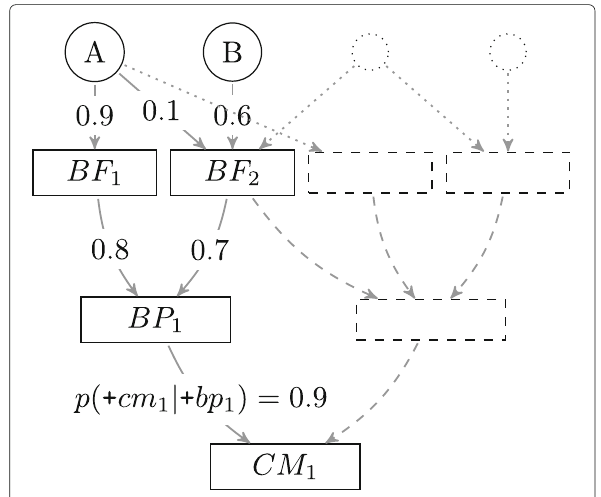
Fig. 1 Mission dependency model. Valuesalongedges denote individual conditional probability